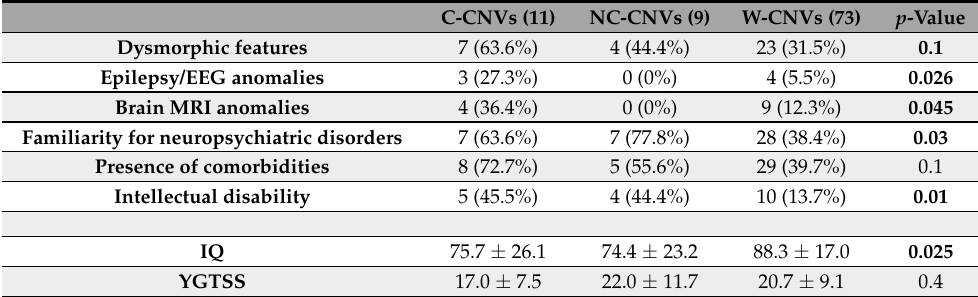
Table 2. Somatic and neuropsychiatric features in patients with TS according to